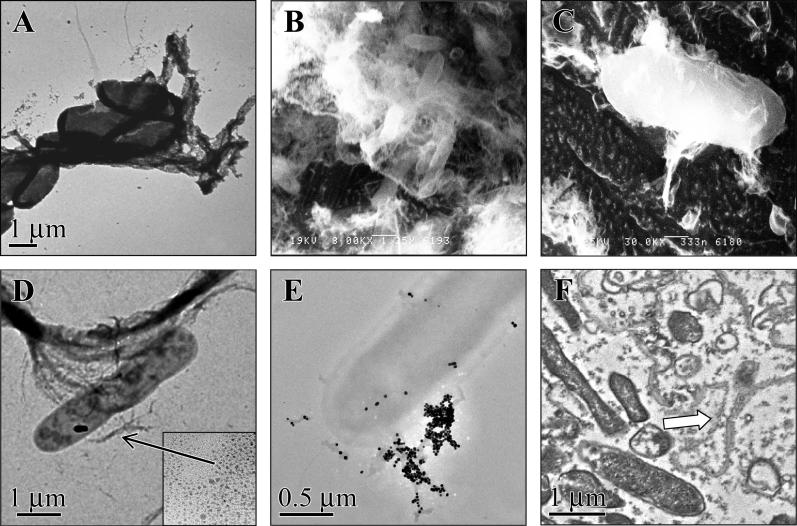
Extracellular Structure of
S. oneidensis MR-1
Whole mounts of MR-1 incubated with 250 μM U(VI) for 24 h prior to visualization by TEM (A) or incubated in defined media and visualized by cryo-HRSEM (B, C). Whole-mount TEM of cells incubated with 1 mM fumarate added as the electron acceptor in place of U(VI) and reacted with positive charged colloidal nanogold particles (D) to help determine surface charge of the EPS matrix or the glycoconjugate-specific lectin, ConA, complexed with 40-nm particles of colloidal gold (E). High-resolution image of 1.4-nm gold nanoparticles (D inset). Thin-section TEM images of MR-1 incubated for 24 h with 1 mM fumarate prior to ruthenium red staining to visualize extracellular EPS (F). The ruthenium red-EPS is designated by the arrow.